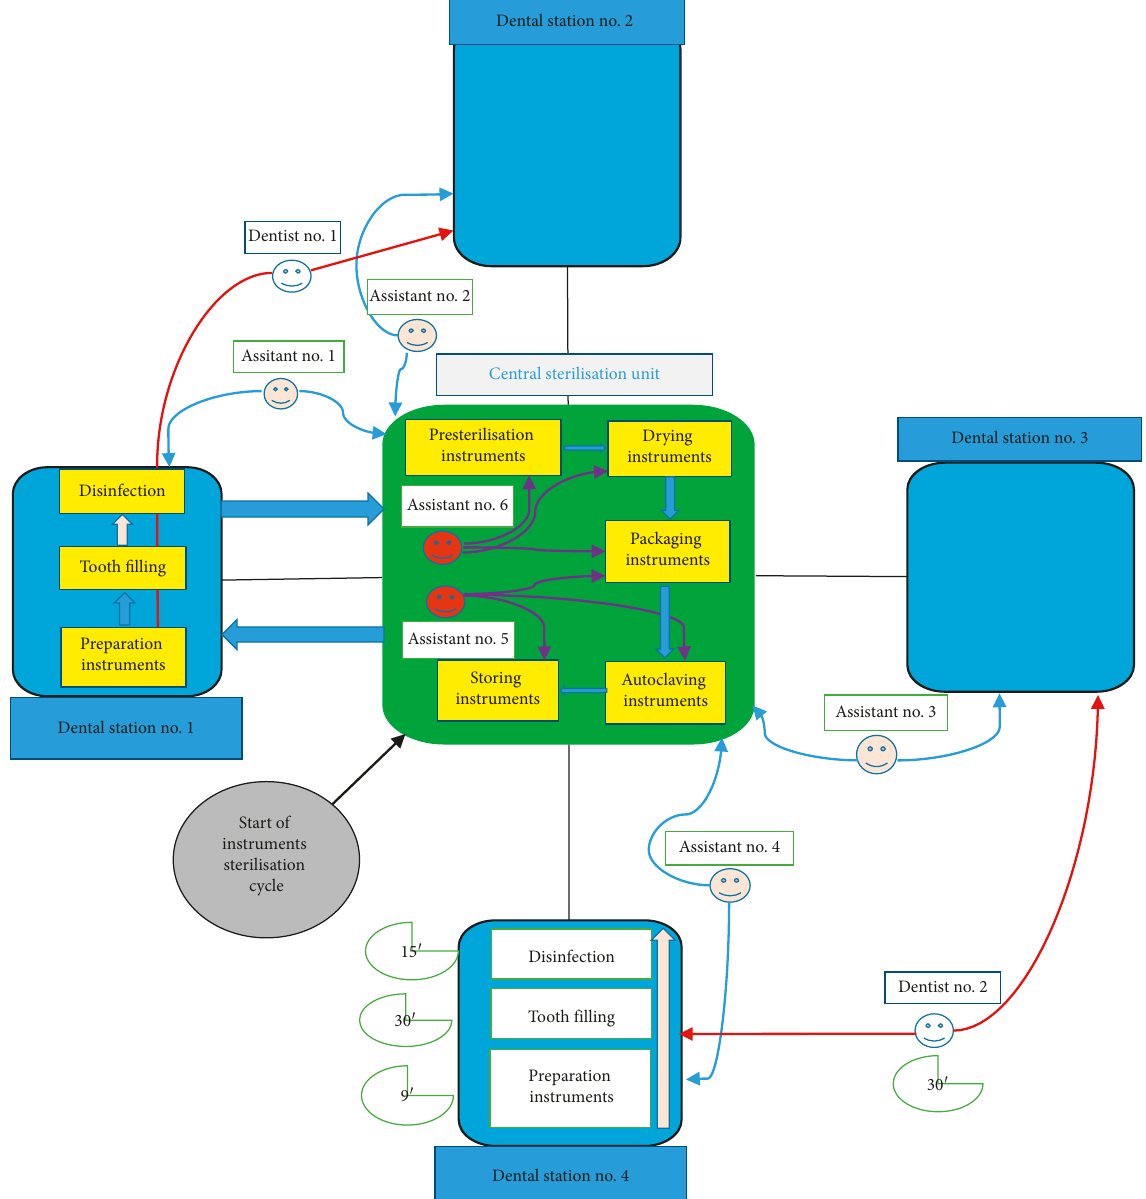
Figure 4: Sterilisation and disinfection cycle of dental instruments, with relative timings and tasks for each member of the dental team (Finding